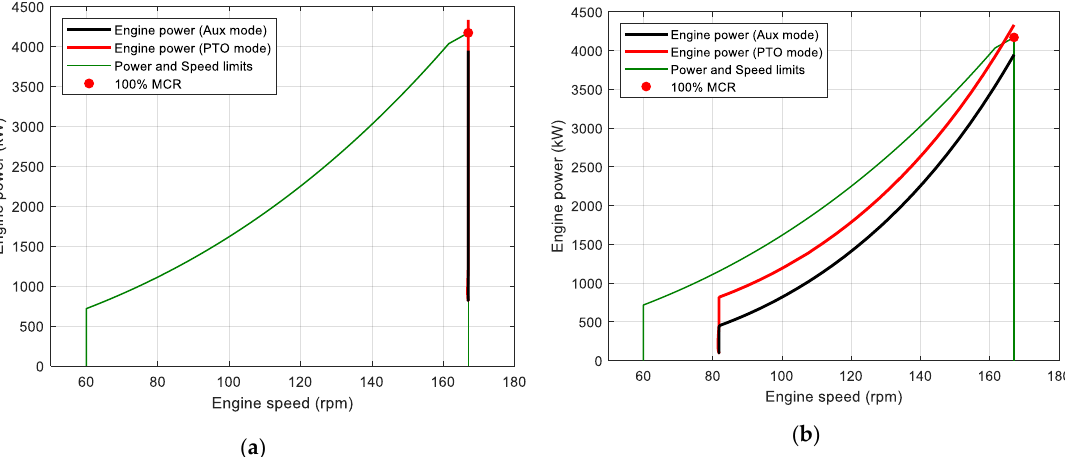
Figure A6. Main engine power in different propulsion control and electric generation modes. ( a ) Constant revolution mode, and ( b ) constant pitch mode.